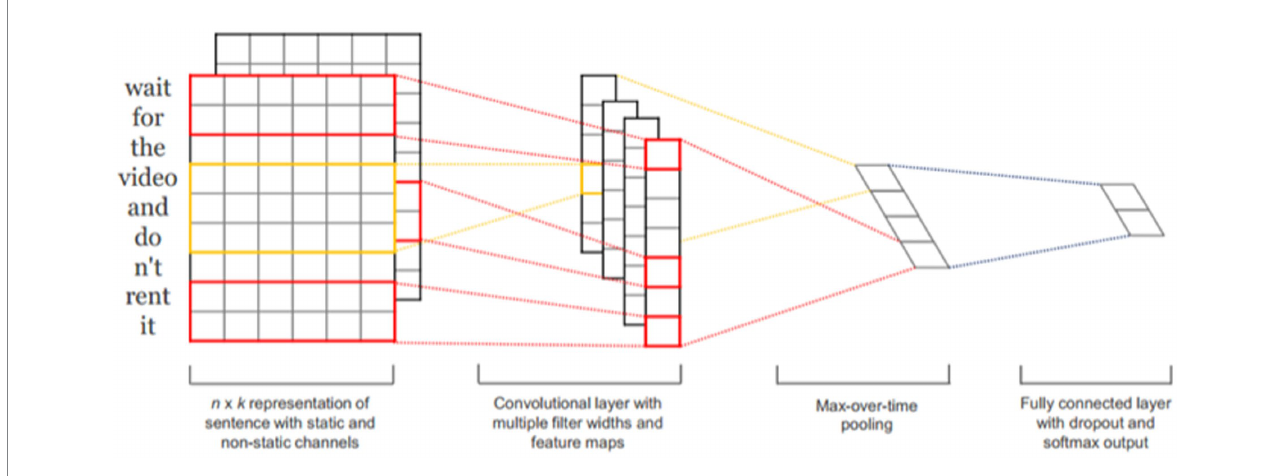
FIGURE 1 Convolutional neural network (CNN) structure (Kim,